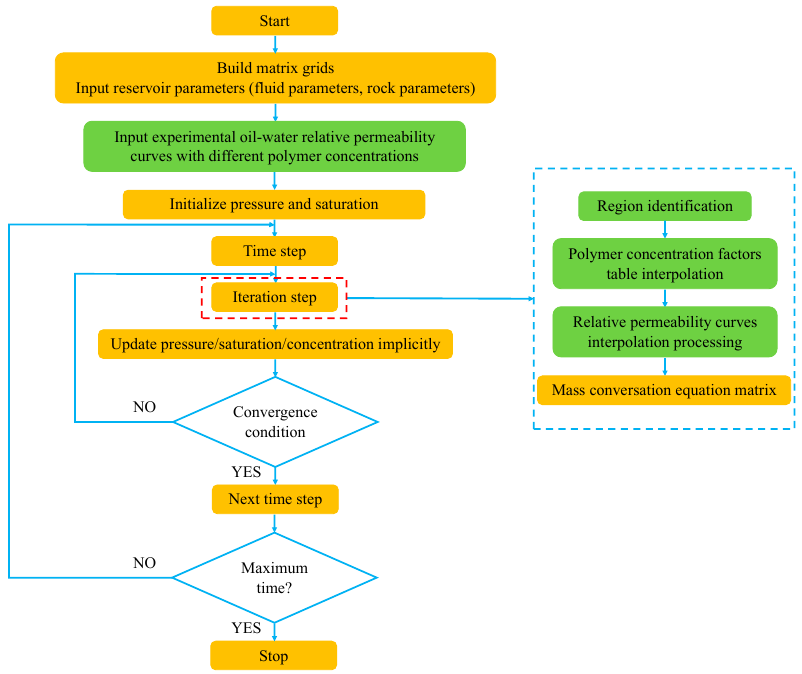
Figure 2. The overall solution workflow of the mathematical model in this work.